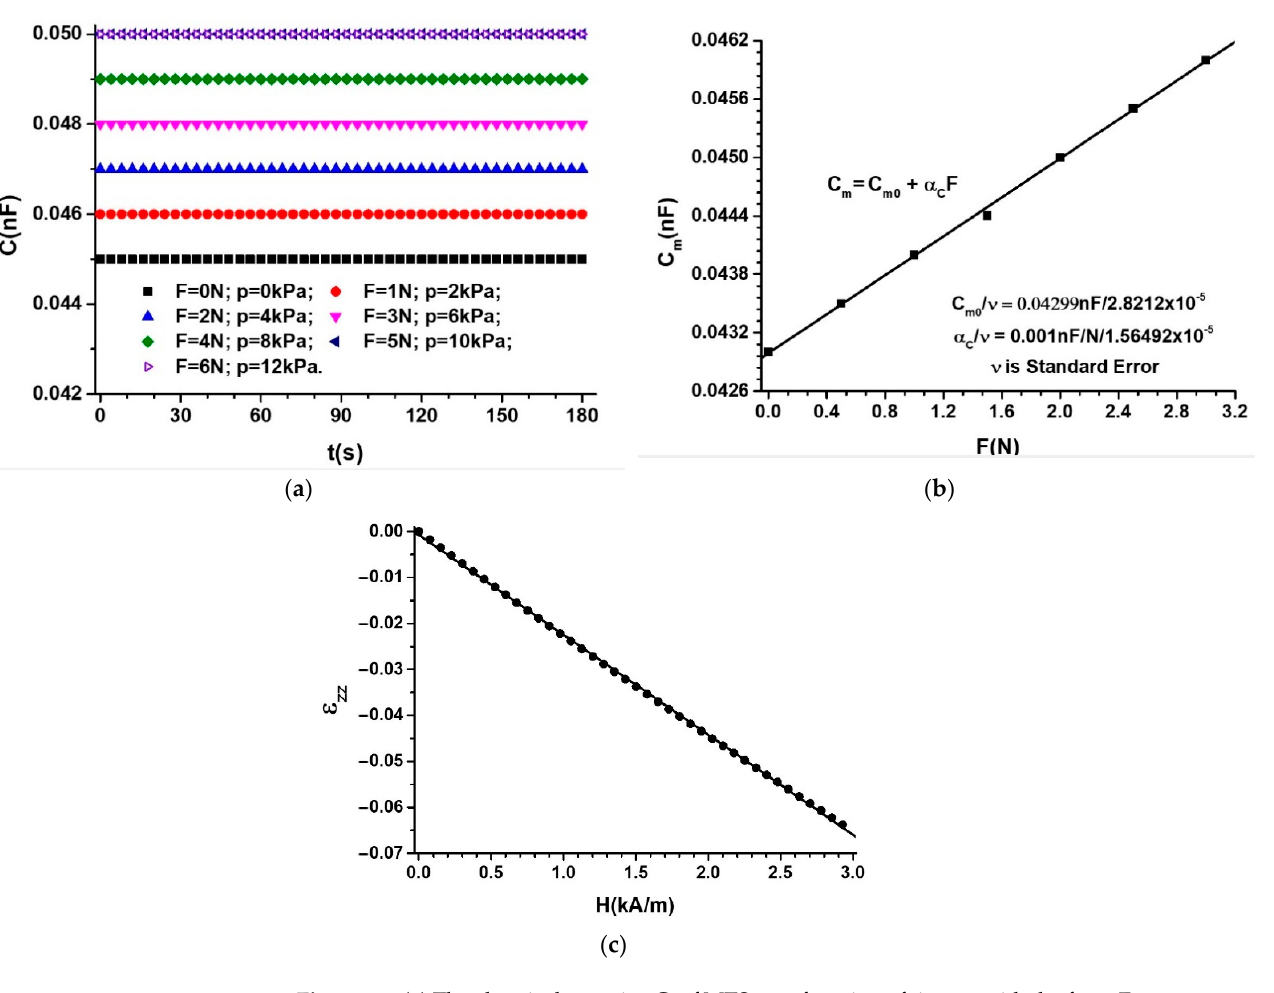
Figure 12. ( a ) The electrical capacity, C, of MTS, as a function of time, t, with the force F as a parameter; ( b ) the average capacity C m of MTS as a function of F; ( c ) the components ε zz of the deformations of MPS as a function of F (dots are experimental data and lines are the first-order polynomial fit).